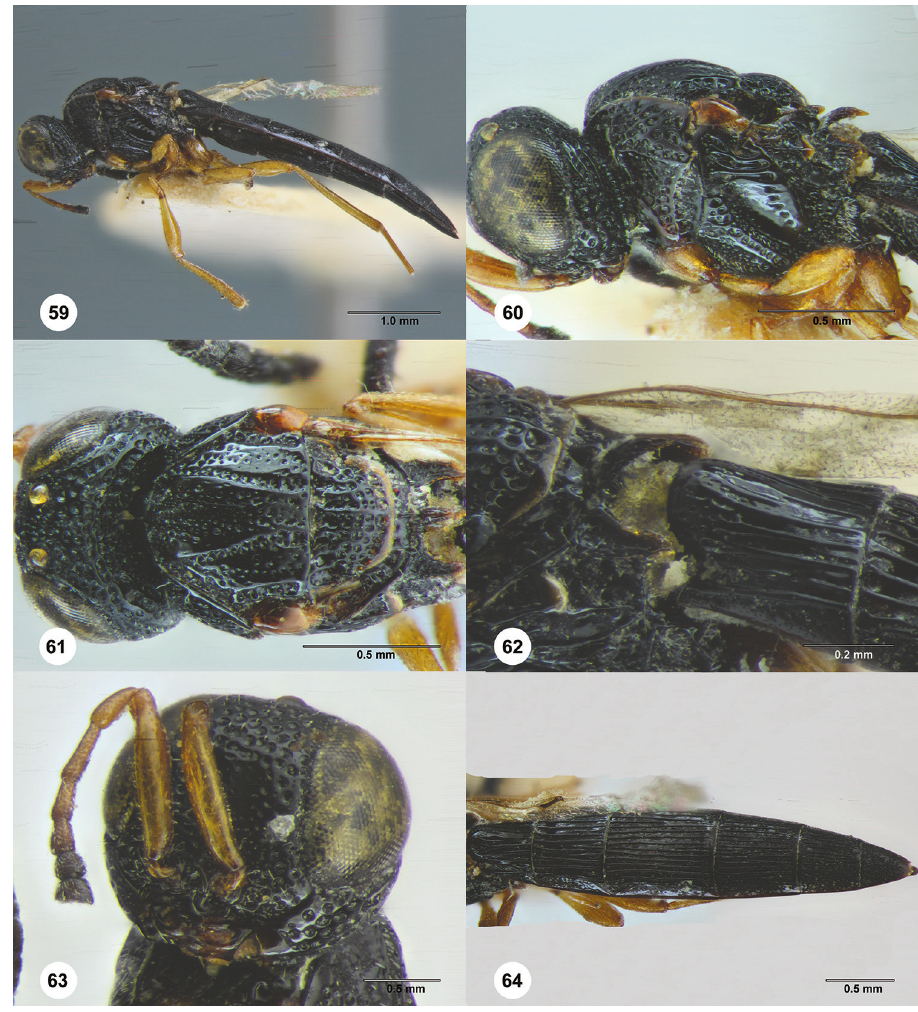
Figures 59–64. Triteleia dagavia , female, holotype (IEBR 0143). 59 Lateral habitus 60 Head and mesosoma, lateral view 61 Head and mesosoma, dorsal view 62 Propodeum, dorsolateral view 63 Head, lateral view 64 Metasoma, dorsal